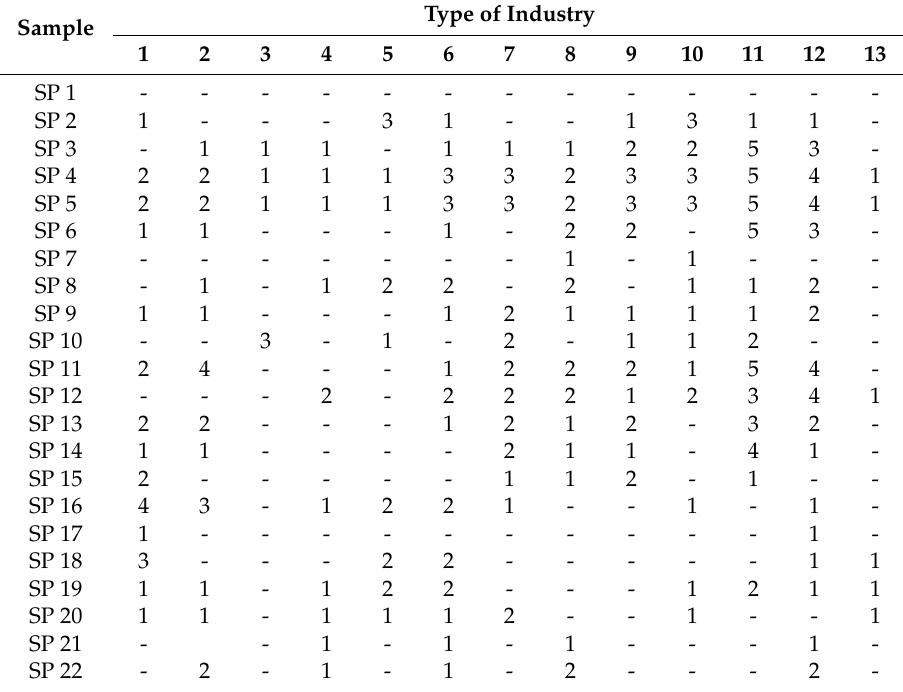
Table 6. Distribution of industries that have a potential for PAE migration in sub-catchments of sampling